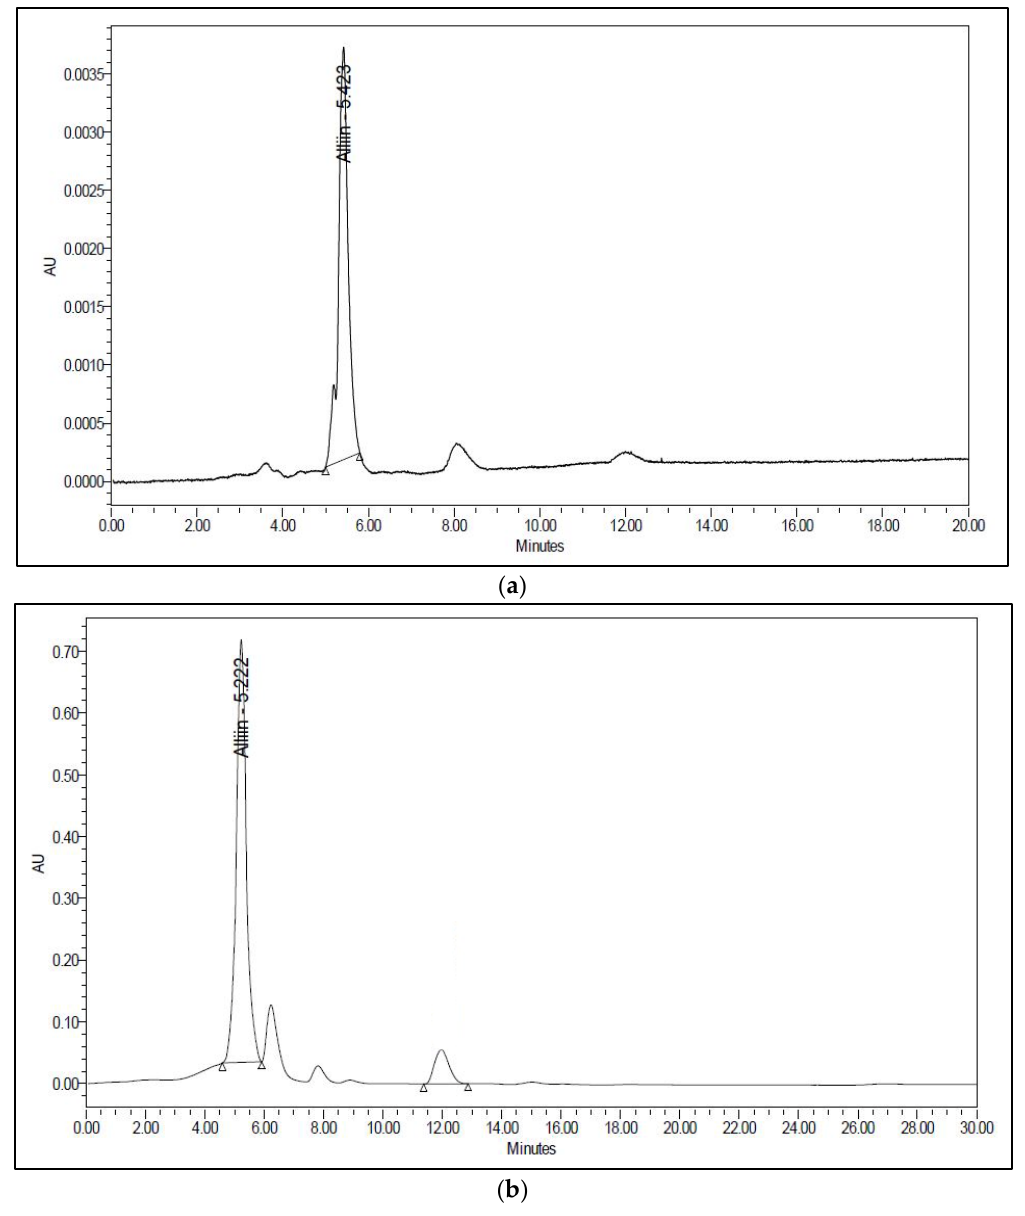
Figure 2. Peak area of ( a ) alliin standard at concentration of 600 ppm; ( b ) garlic extract consisting of alliin at 180 C and 2 mL/min for a 10 min extraction time.